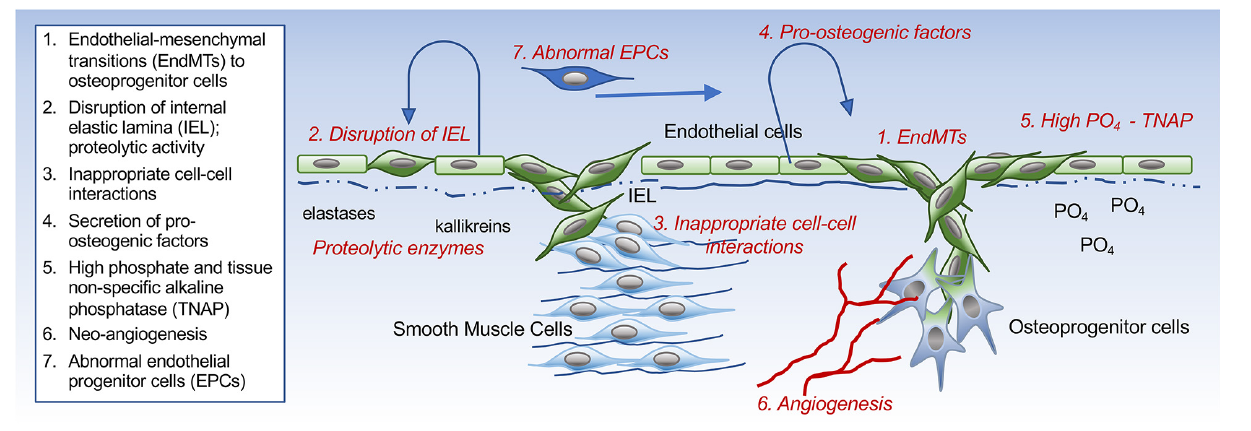
FIGURE 2 | Schematic drawing. Different ways the endothelium can influence the development of vascular calcification.